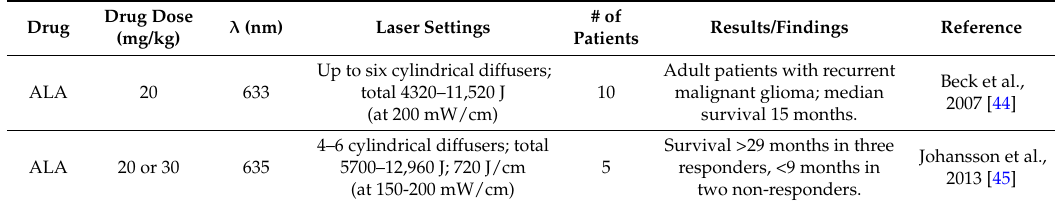
Table 4. Representative I-PDT treatments for brain